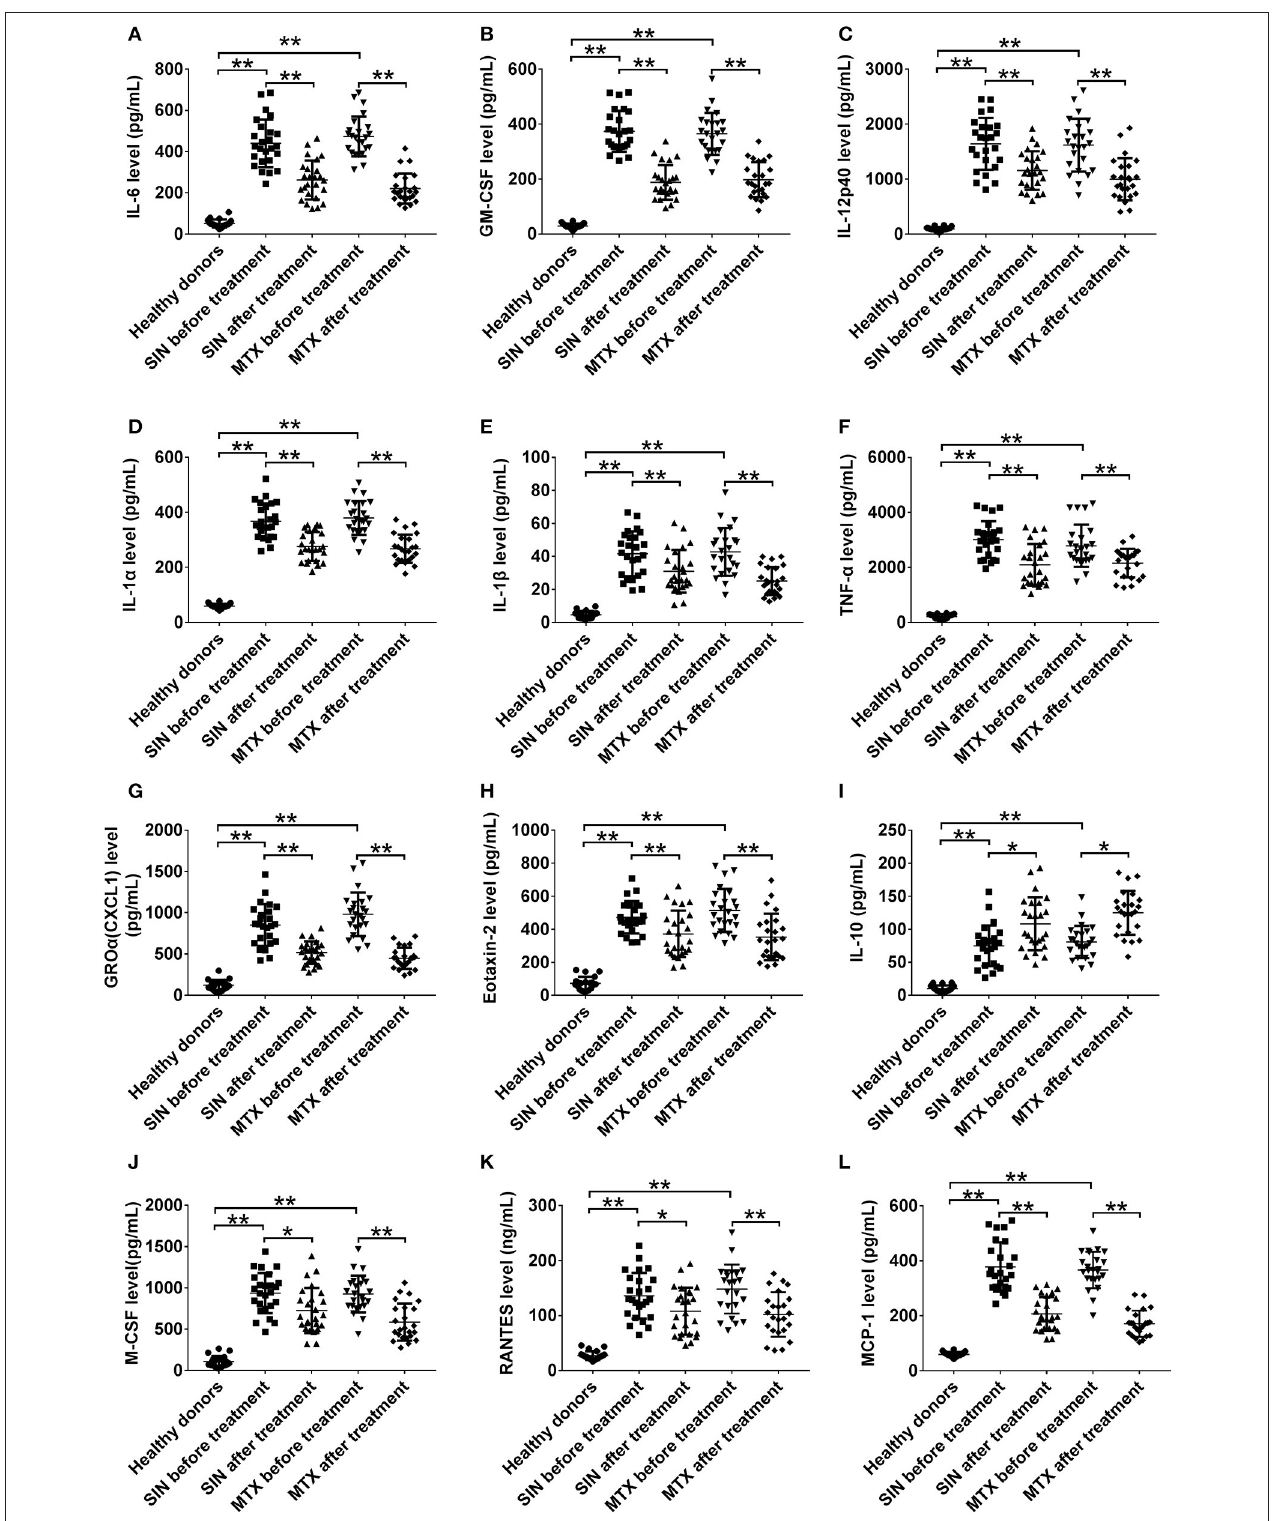
FIGURE 7 | SIN modulates the secretory levels of inflammatory cytokines in the plasma of RA patients. (A) IL-6, (B) GM-CSF, (C) IL12-p40, (D) IL-1 α , (E) IL-1 β , (F) TNF- α , (G) GRO α (CXCL1), (H) Eotaxin-2, (I) IL-10, (J) MCSF, (K) RANTES, and (L) MCP-1 secretion was detected by ELISA in heathy donors, before and after SIN and MTX treatments, respectively. Each dot represents one sample. Significance was analyzed by unpaired two-sided t -test (* P < 0.05, ** P < 0.01).